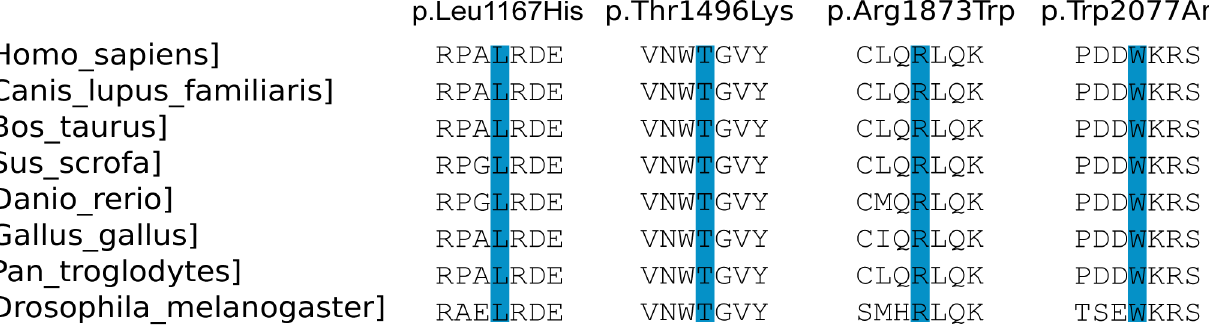
PLOS ONE | https://doi.org/10.1371/journal.pone.0176516 May 4,